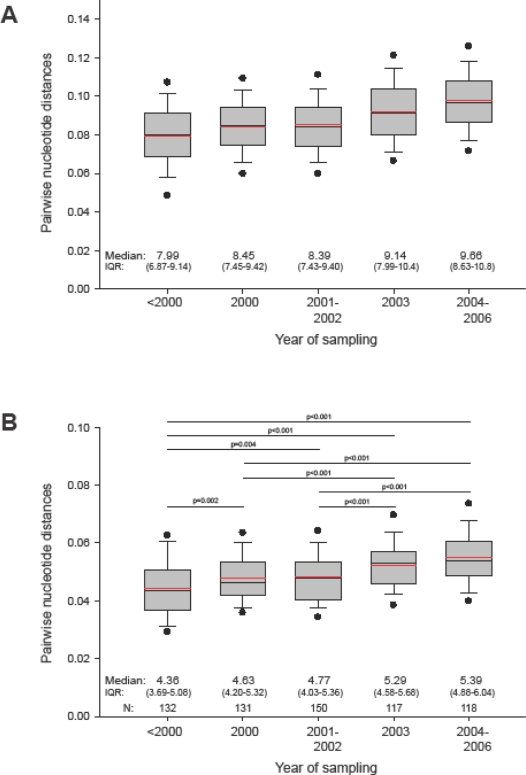
Pairwise distances of HIV-1 subtype C gag sequences collected at different time points. In the box plots: The boundary of the box closest to zero indicates the 25th percentile, a black line within the box marks the median value, a red line within the box shows the mean, and the boundary of the box farthest from zero indicates the 75th percentile. Whiskers above and below the box indicate the 10th and 90th percentiles. Points above and below the whiskers indicate the 5th and 95th percentiles. Five groups in each graph correspond to the time of sampling. A: Pairwise distances within group by sampling time. B: Pairwise distances to HIV-1 subtype C consensus. Comparisons between groups are based on Mann-Whitney sum rank test.